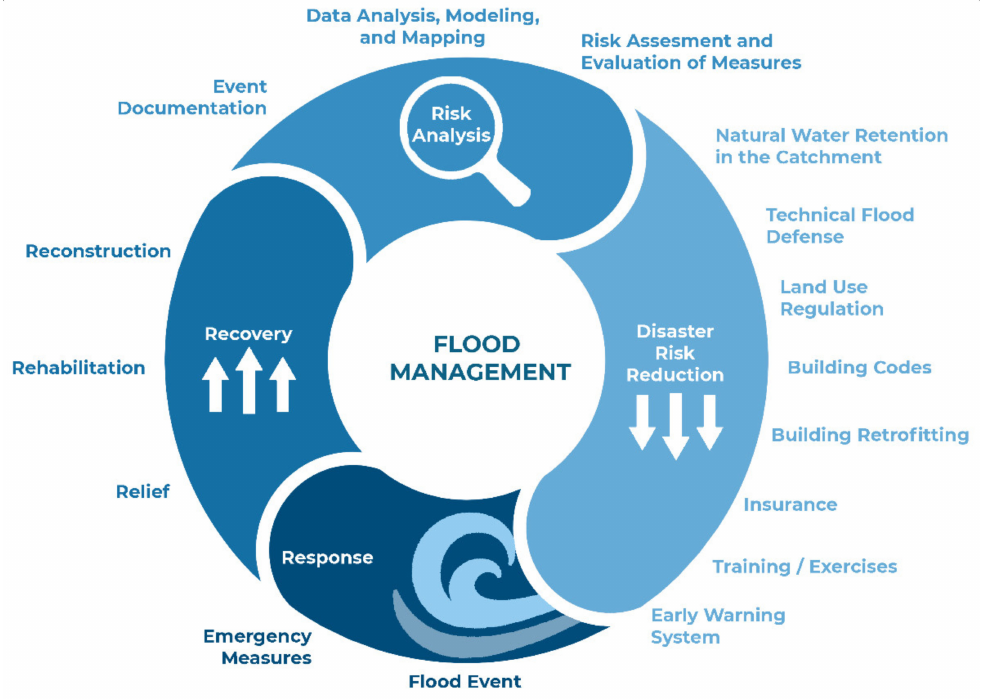
Figure 1. Management cycle in flood management (FM) inspired by [43]. Reproduced with permis- sion from Annegret